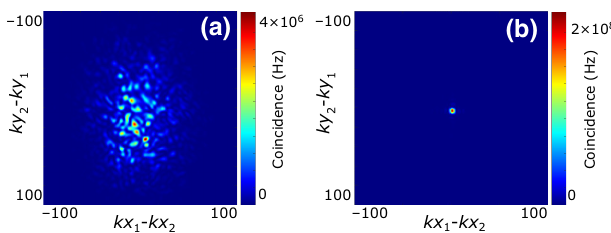
FIG. 9. Simulated two-photon output fields. Sum-coordinate projections of | (cid:4) out | 2 obtained with (a) a flat phase pattern and the (b) correction phase pattern. The spatial coordinates are in